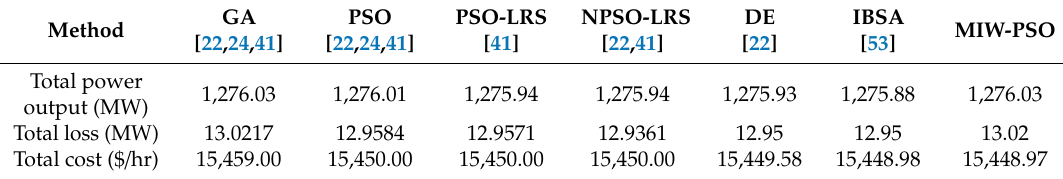
Table 9. Simulation result comparison on the third case